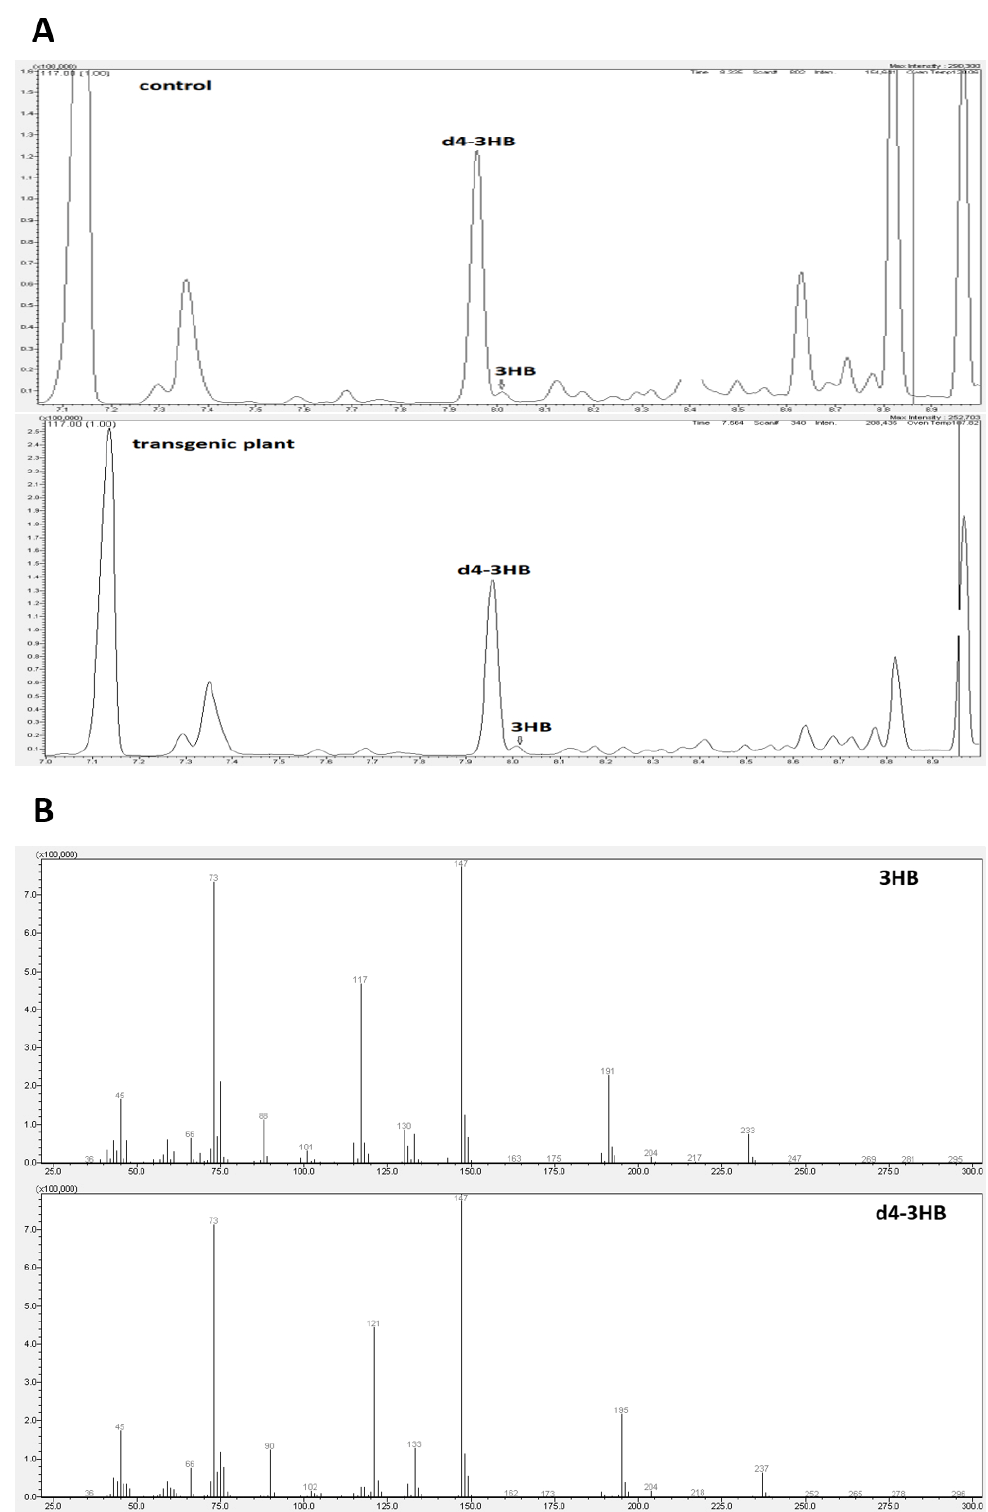
Figure 2. Composition analysis of extracted material from control and transgenic flax with the identification of 3-hydroxybutyrate (3-HB) by GC-MS. ( A ): Counts vs. acquisition time (min) for control (upper panel) and transgene (down panel). ( B ): Counts vs. mass charge ratio (m / z) for 3-HB (upper panel) and deuterated 3-HB (down